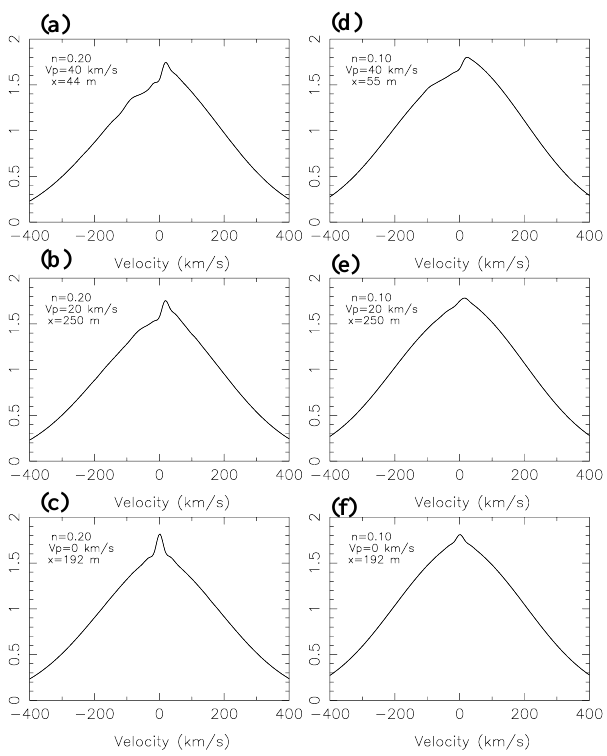
Fig. 5. Individual EDFs near density